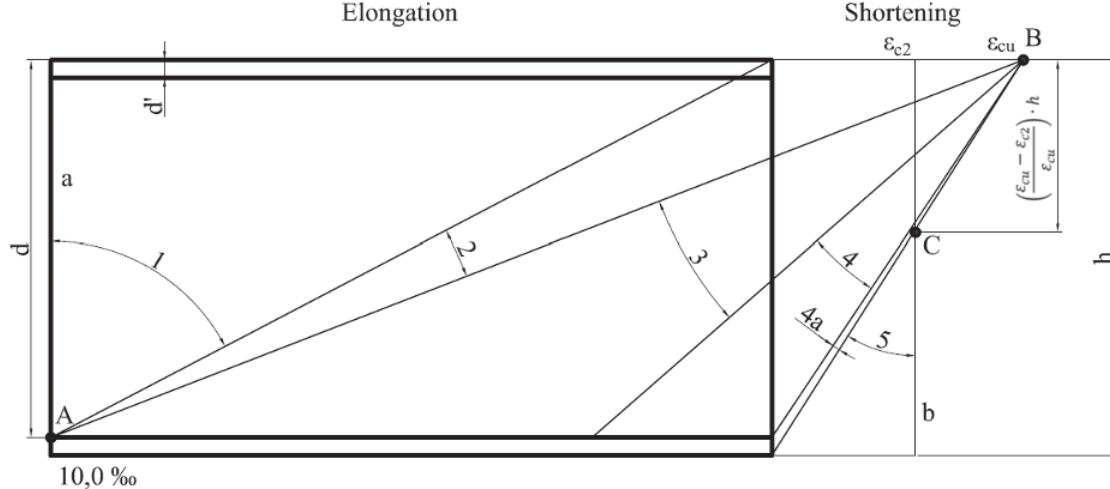
Strain distribution diagram at failure – adapted from NBR-6118:2014, ABNT